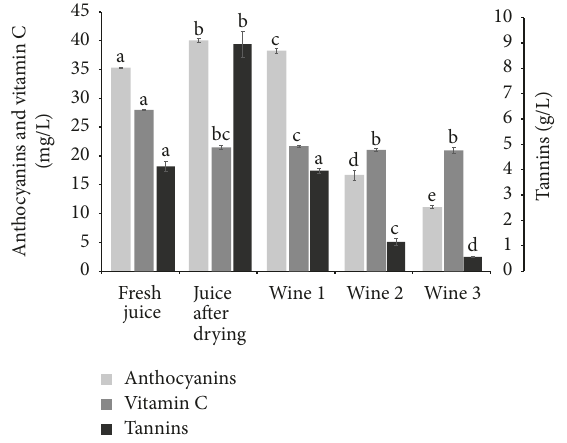
Figure 2: Changes in anthocyanins, vitamin C, and tannins of blueberry juices and wines. 𝑁 = 3 . Columns of the same parameter with different superscript letters are significantly different, 𝑝 = 0.05 .